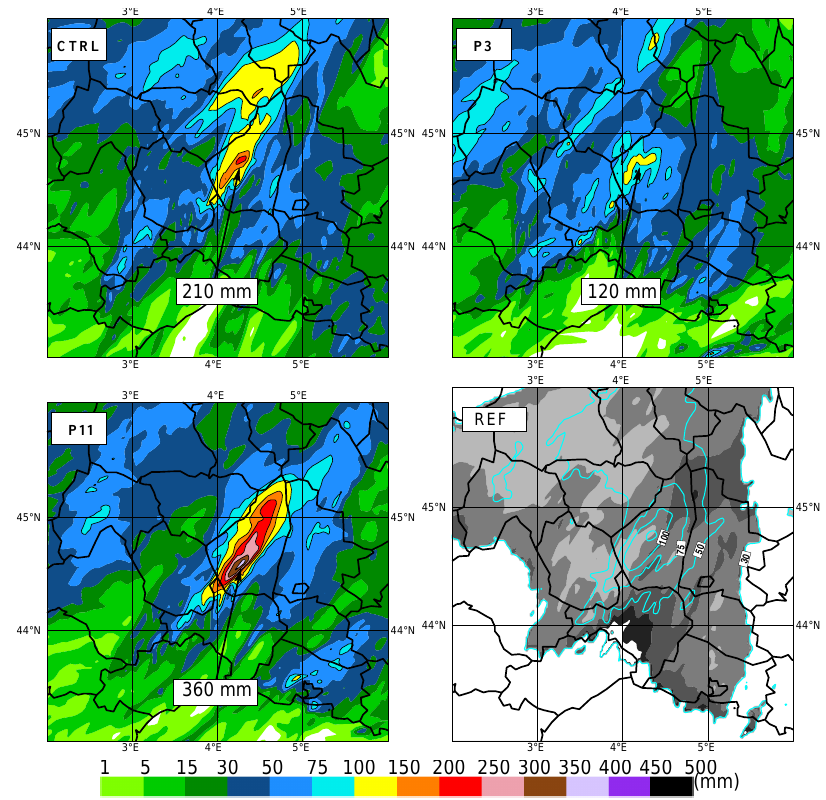
Fig. 8. Gard case 24-h accumulated simulated precipitation for the REF convective-permitting ensemble experiment. The run is valid for 08 September 2010 at 06 UTC and starts on 07 September 2010 at 00 UTC. Precipitation maxima are pointed out over the Gard department. The last panel shows the 24-h accumulated ensemble-mean (solid line) and the normalised spread (shading). The spread is not shown for precipitation below 30 mm day − 1 .